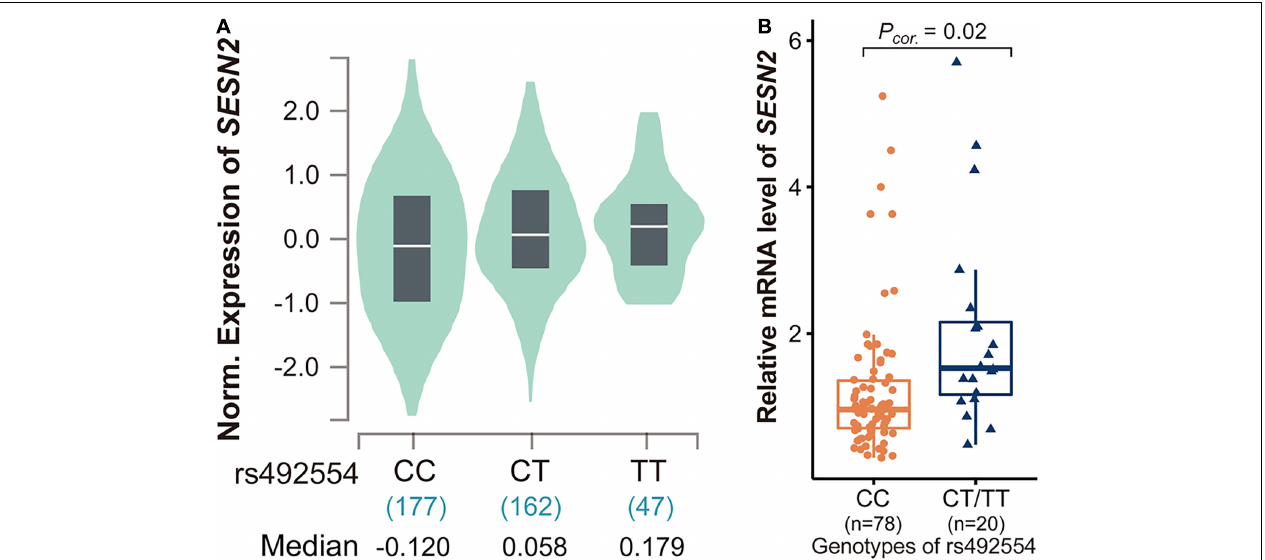
FIGURE 1 | Analysis of expression quantitative trait locus (eQTL) effects at SESN2 . (A) SESN2 displayed a significant eQTL association with rs492554 genotypes (T is the protective allele and C is the risk allele) in 386 left cardiac ventricular tissues of the Genotype-Tissue Expression (GTEx) database ( P = 2.5 × 10 − 6 ). (B) Relative mRNA expression levels of SESN2 in 98 myocardial tissues with rs492554 genotypes. Gene expression data were analyzed by two-tailed unpaired Student t -test with Welch’s correction for unequal variances.